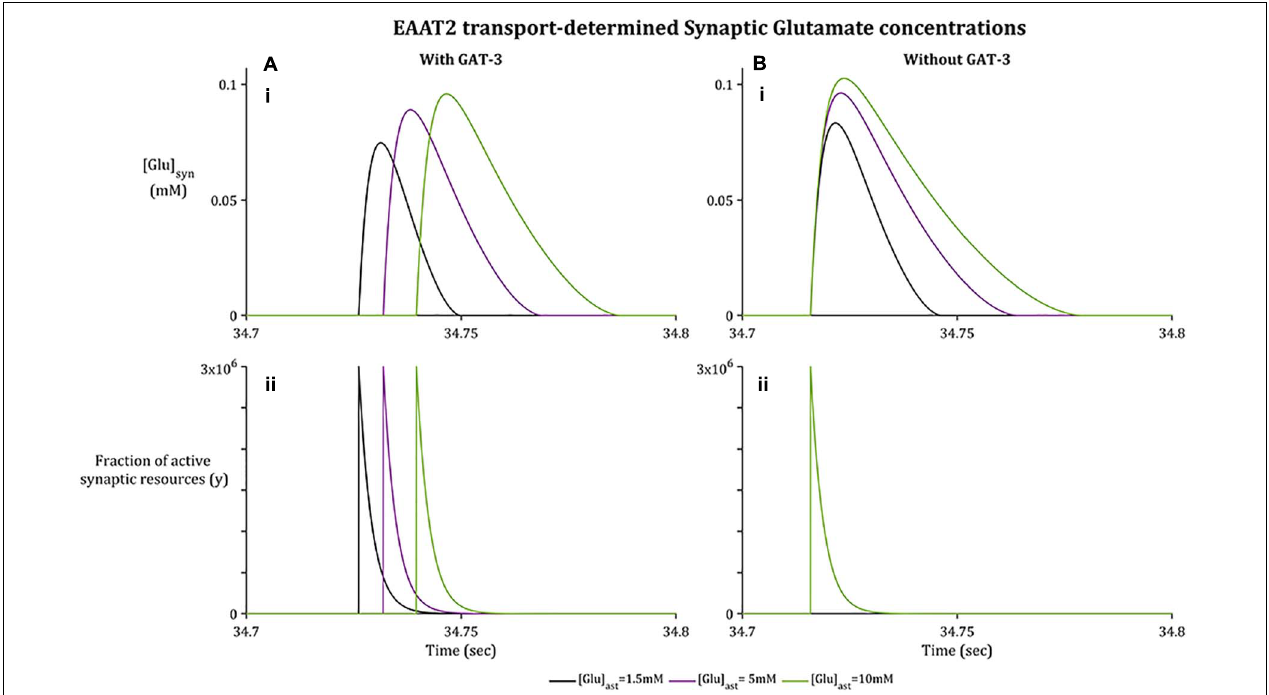
FIGURE 3 | Synaptic [Glu] dynamics for a 0.1 s window within the simulation associated with basal [Glu] ast . (A.i) shows [Glu] syn increasing to a higher concentration where the basal [Glu] ast is higher, despite the fraction of active synaptic resources (A.ii) being identical in all cases. Within (B.i) , [Glu] syn increases to a higher concentration again for all [Glu] ast where the GAT3-mediated transport is not included, again despite an identical fraction of active resources (B.ii) being released by the presynaptic neuron.